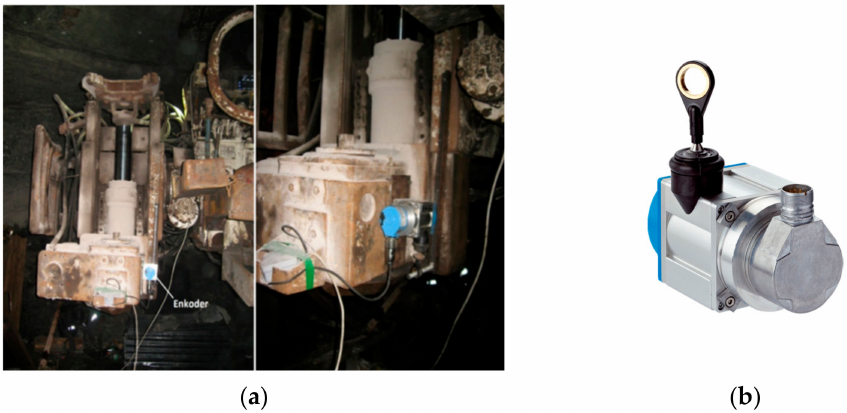
Figure 6. Instrumented drilling rig ( a ) Roof Master 1.4 ( b ) Linear encoder HighLine PRF08- E1AM0340encoder https://www.sick.com/media/pdf/4/14/514/dataSheet_PRF08-E1AM0340_ 1034898_pl.pdf (accessed on 12 December